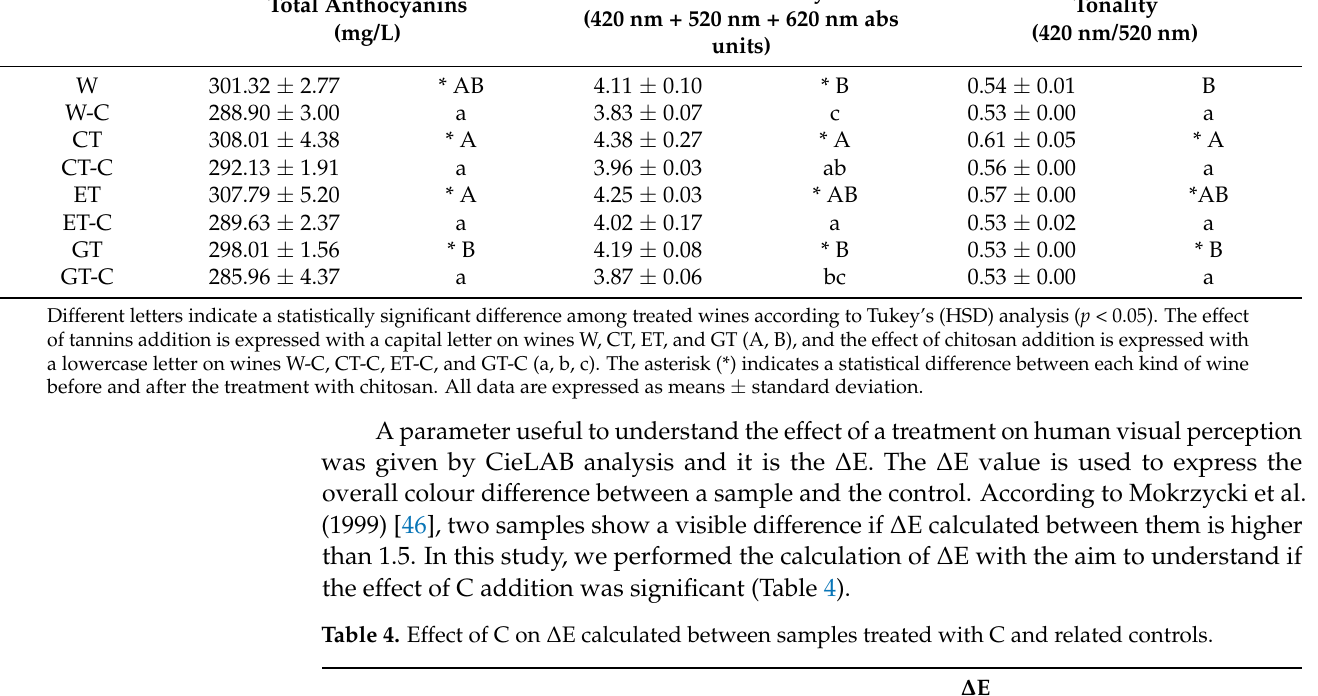
Table 3. Effect of tannins and C on total anthocyanins, colour intensity, and tonality (evaluated by using spectrophotometric methods). Colour Intensity Total Anthocyanins (420 nm + 520 nm + 620 nm abs (mg/L) units)